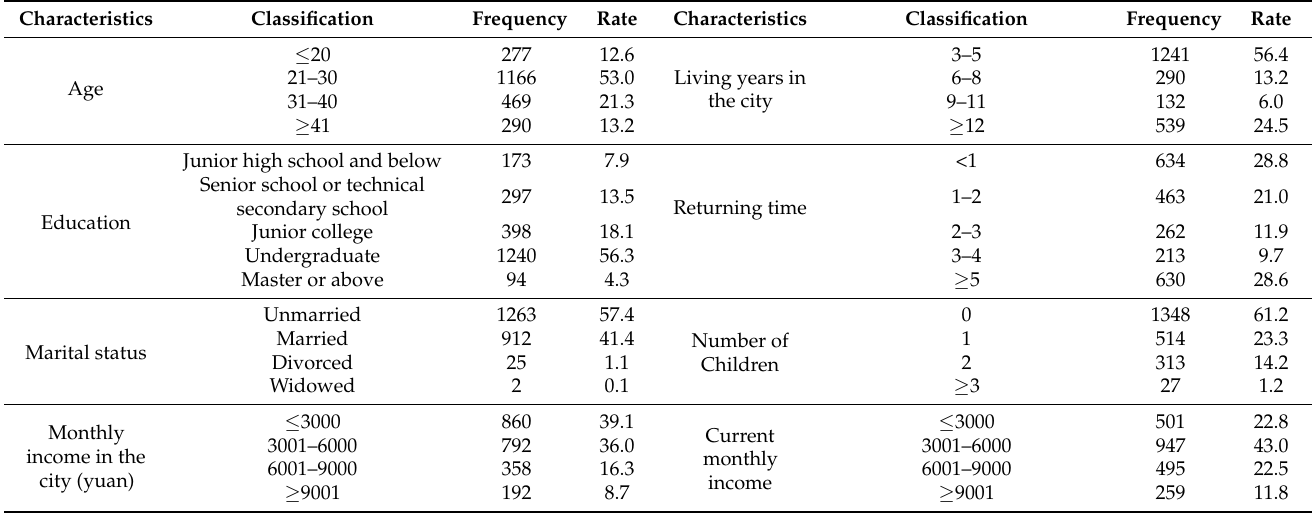
Table 1. Descriptive information on the